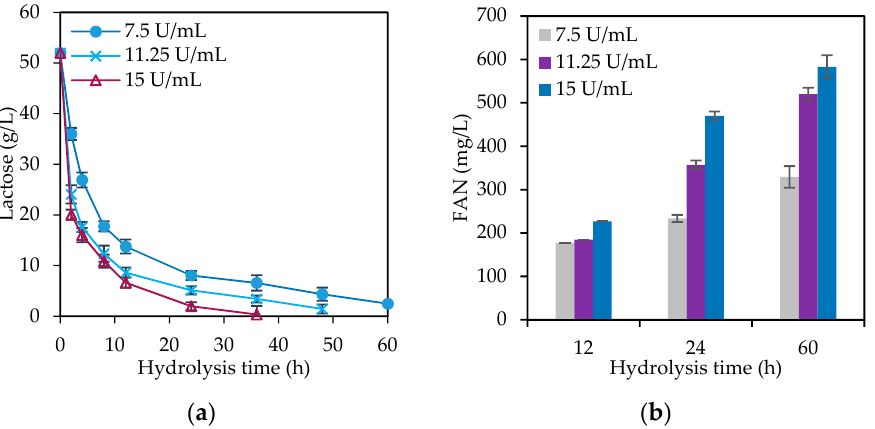
Figure 4. Effect of different initial enzymatic activity of crude β -galactosidase on cheese whey (CW) hydrolysis. Kinetics of ( a ) lactose hydrolysis and ( b ) free amino nitrogen (FAN) production.